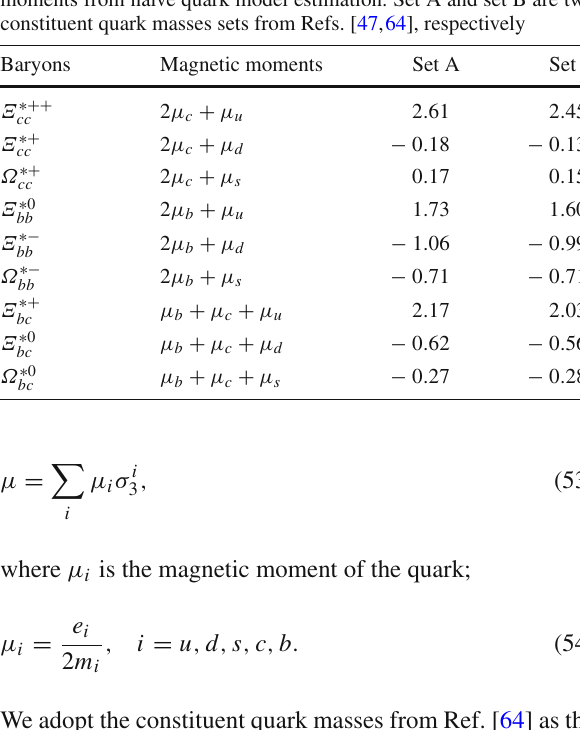
doublyheavybaryonmagnetic 2